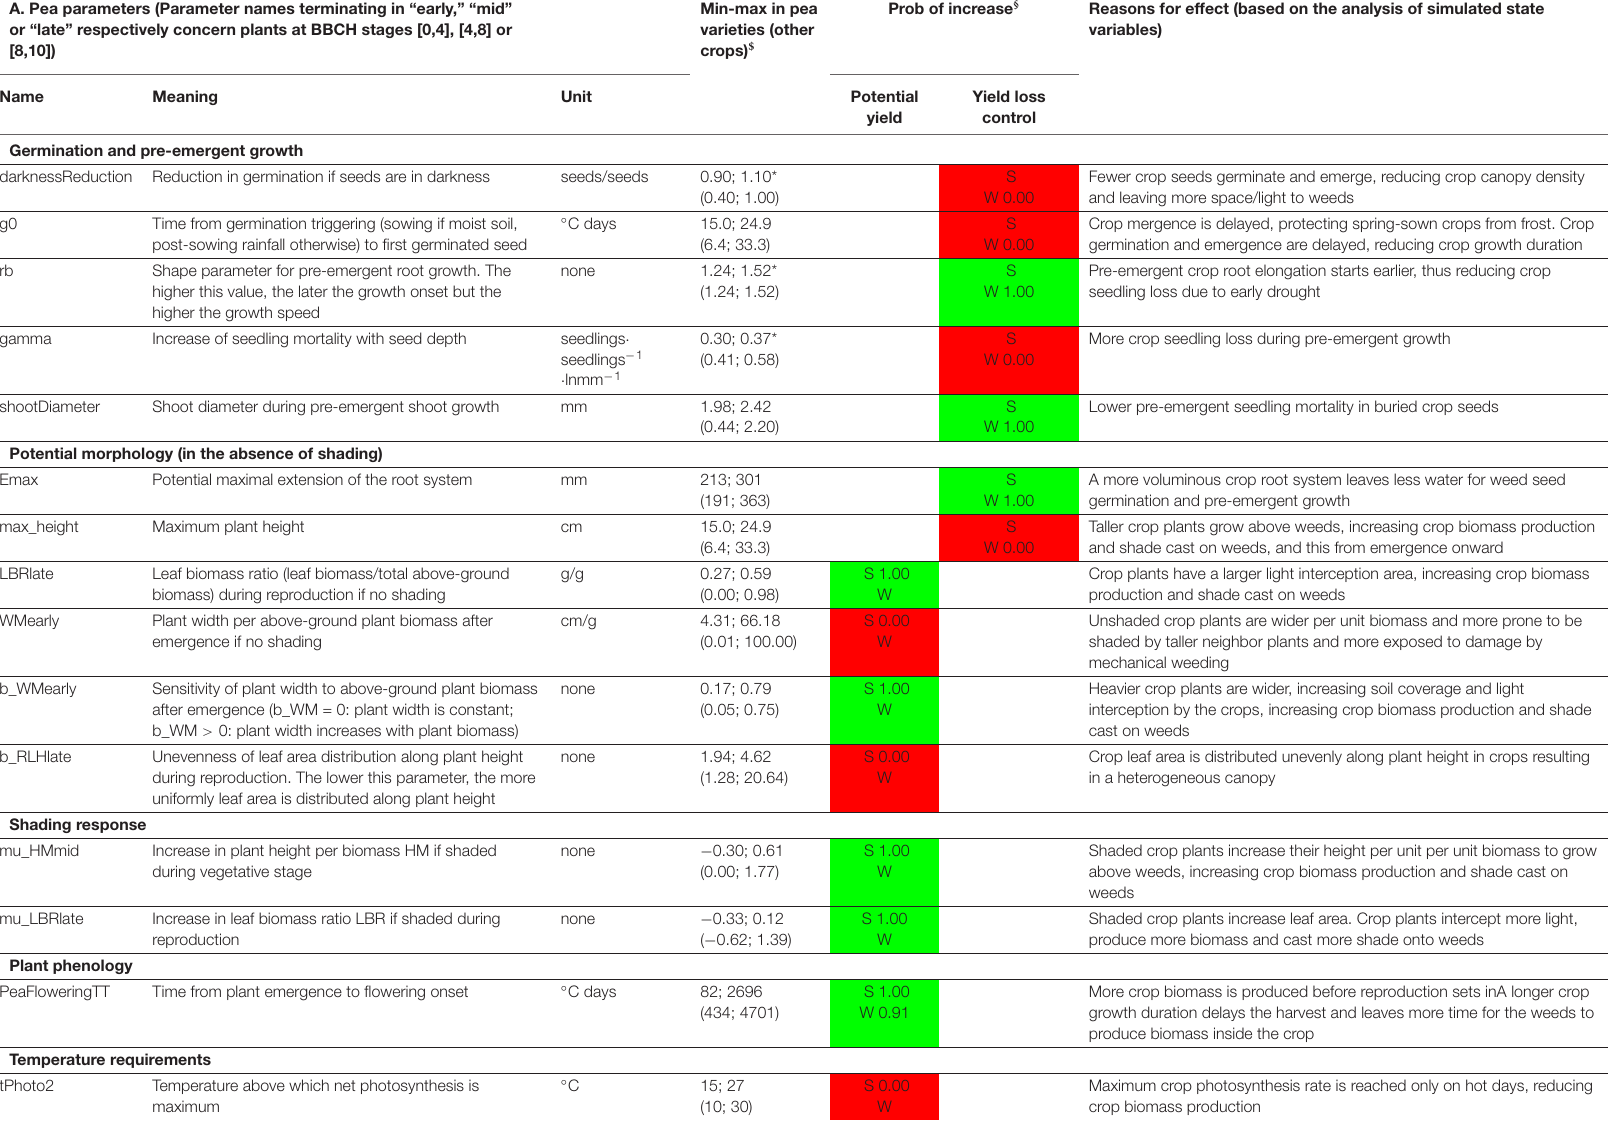
Reasons for effect (based on the analysis of simulated state